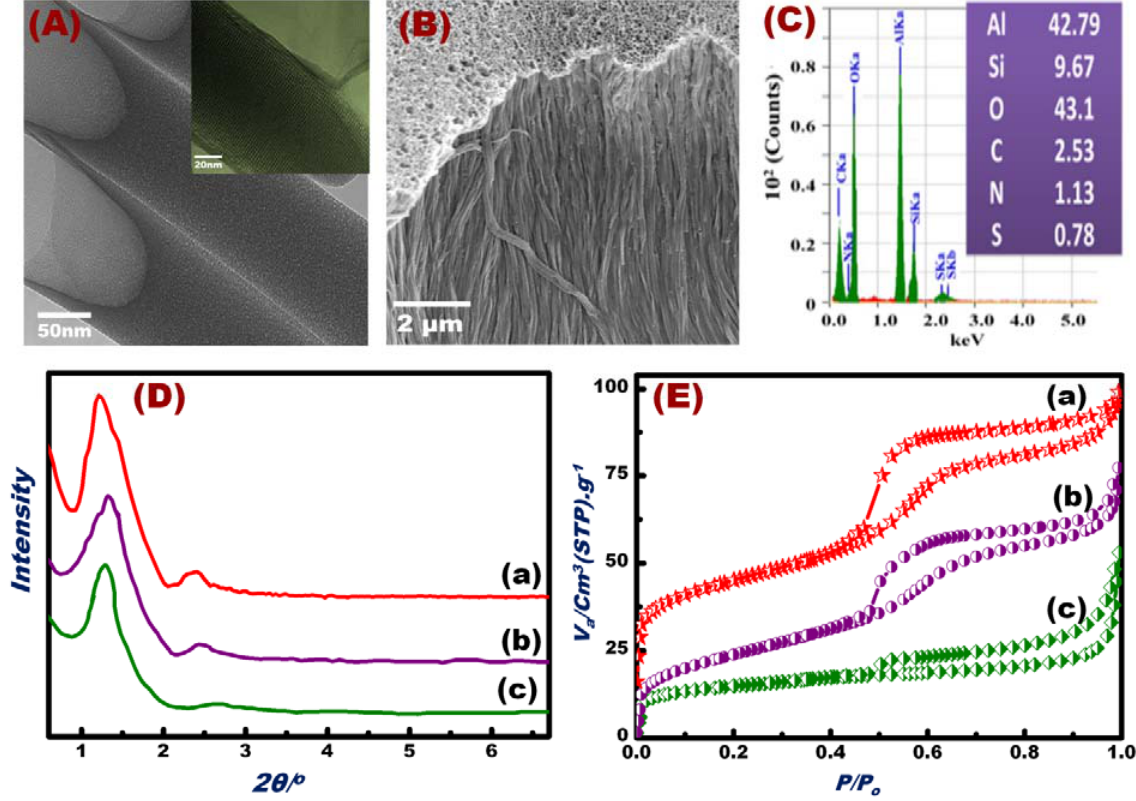
Figure 1. HRTEM micrograph patterns of the OSM ( A ). FESEM micrographs of the OSM ( B ) and EDS of the fabricated OSM indicate the presence of Si, Al, O, C, S, and N ( C